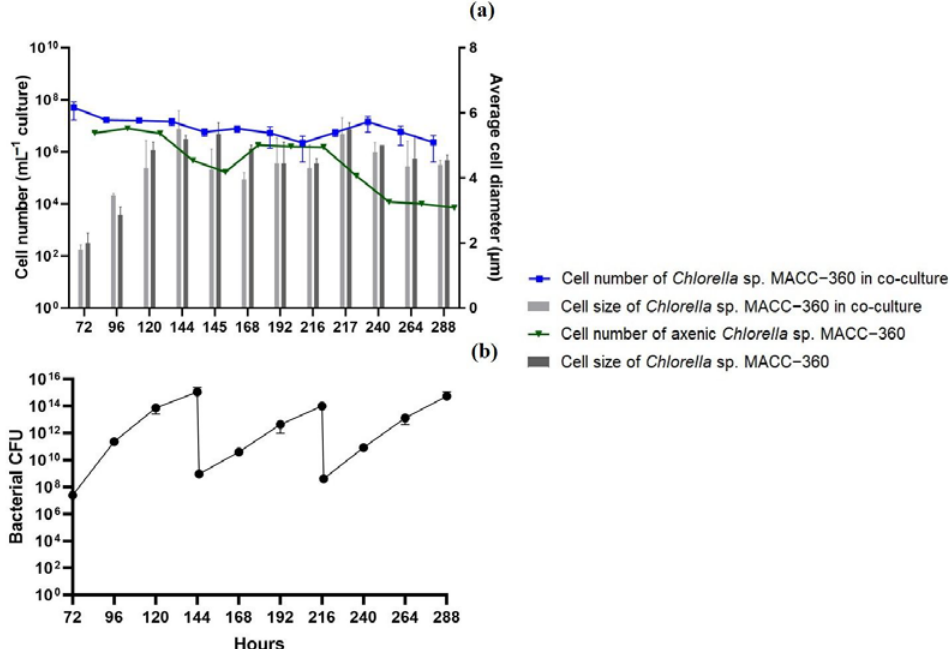
Figure 6. Algal cell number and average cell size (diameter) of Chlorella sp. MACC-360 in acetate-free TP medium containing 8 g L − 1 starch in experiments where the initial B. amyloliquefaciens OD 600 value was 0.175 ( a ). Colony forming units (CFU) of the partner bacterium throughout the experiment ( b ). Error bars are standard deviations based on three replicates.